Question: What form of chart is displayed?
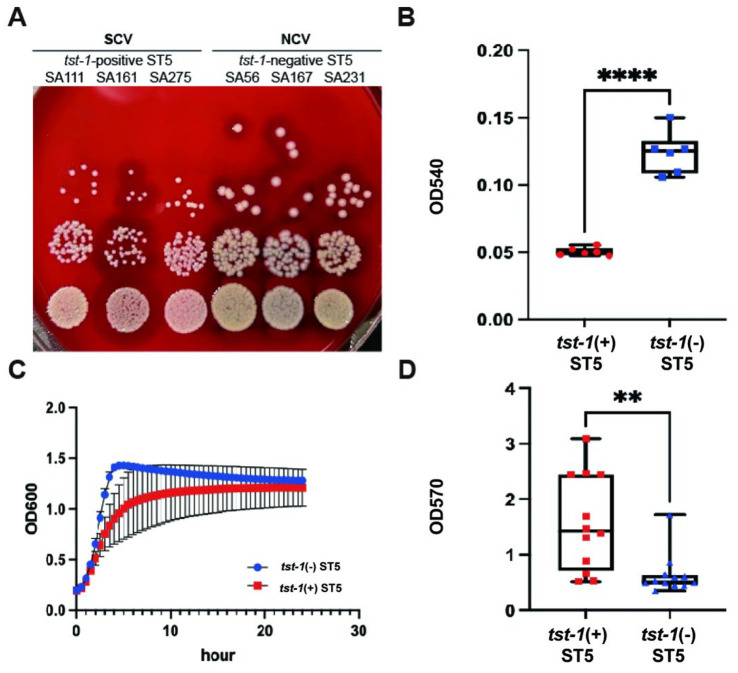
Answer: line